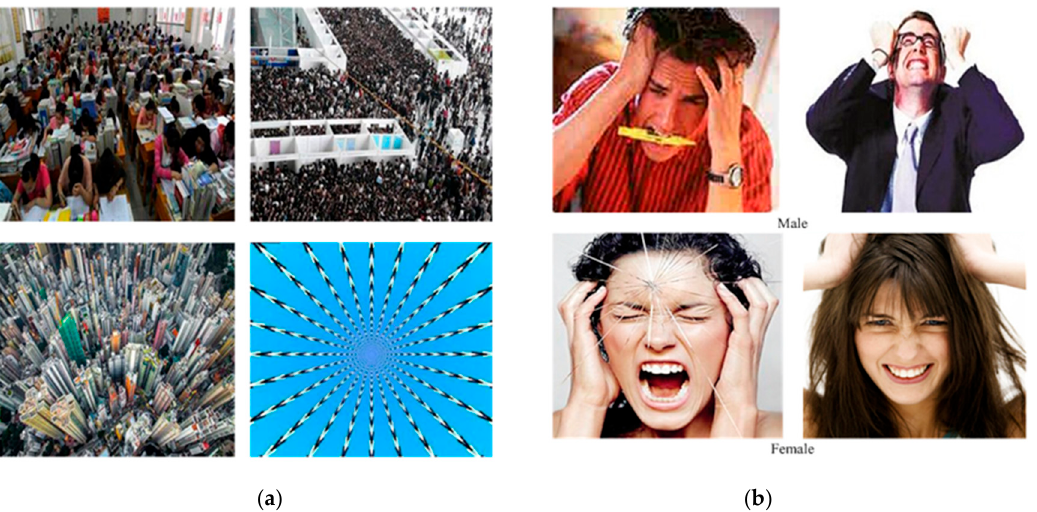
Figure 2. Parts of the anxiety-induction material. ( a ) Visual stimulus; ( b ) Faces of anxiety.